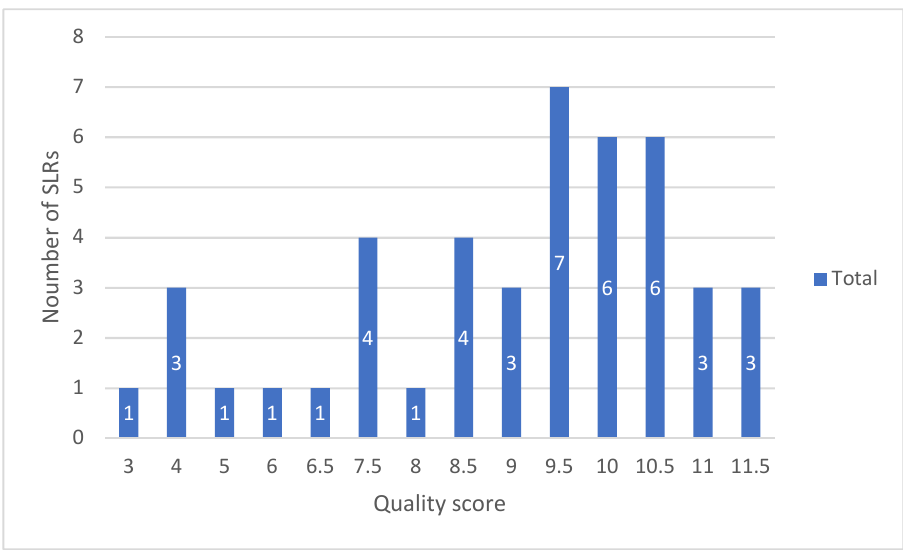
Figure 4. Quality scores of SLRs.